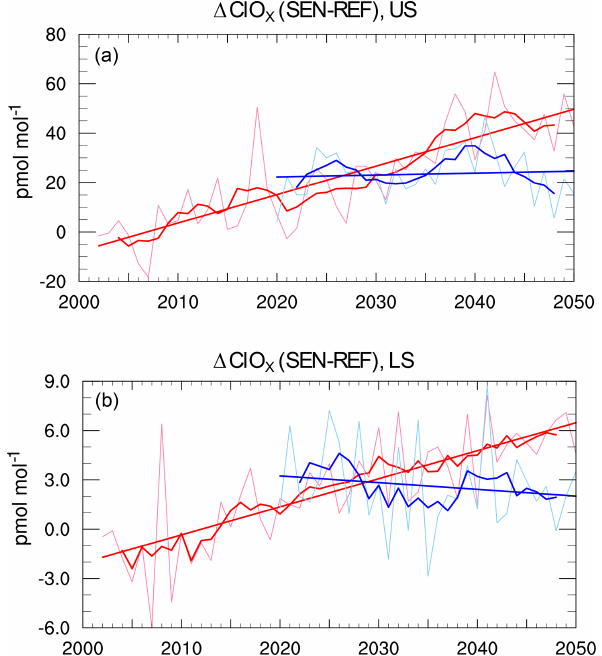
Figure 2. Temporal evolution of the annual global mean ClO x mix- ing ratio differences (in molmol − 1 ) at around 2hPa (US, a ) and 50hPa (LS, b ) between the SEN-C2-fCFC11_2050 and REF-C2 simulations (in red) and between the SEN-C2-fCFC11_2020 and REF-C2 simulations (in blue). The 11-year solar cycle (smoothed with a 1-2-1 filter) has been removed from both time series. The thicker curves in red and blue show the 5-year running means. The red and blue lines show the linear regression estimate of the un- smoothed time series.